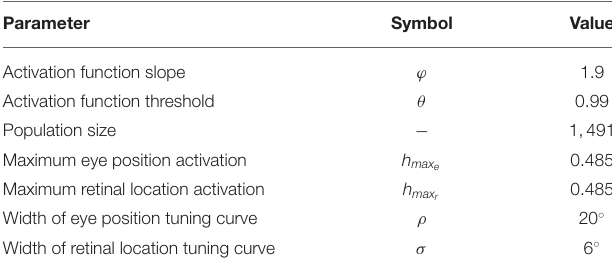
TABLE 1 | Simulation parameters of hardwired